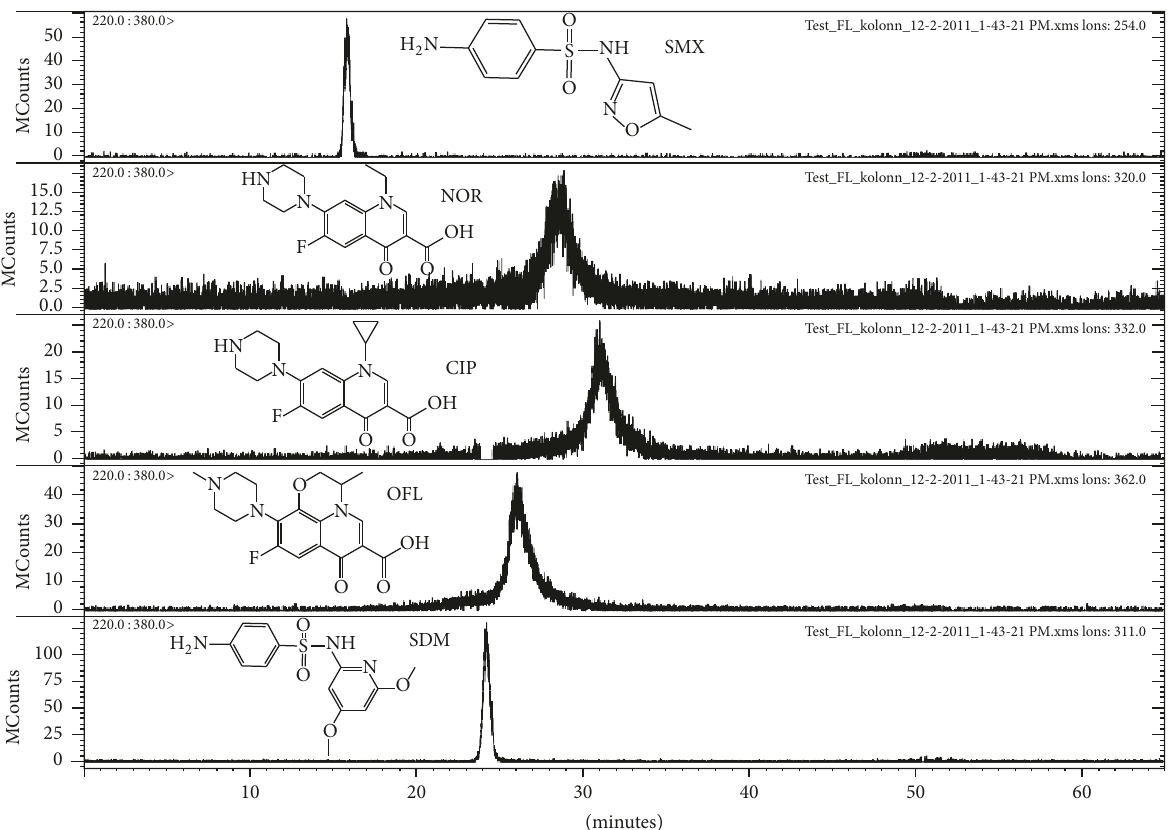
Figure 2: MS chromatogram for the standard solution of FQs and SAs (10 𝜇 g/g). Eluent: (ammonium acetate, formic acid pH 2.8) and MeOH. Used analytical column: Epic FO-LB C8 column (150 mm × 3mm, 3.5 𝜇 m).